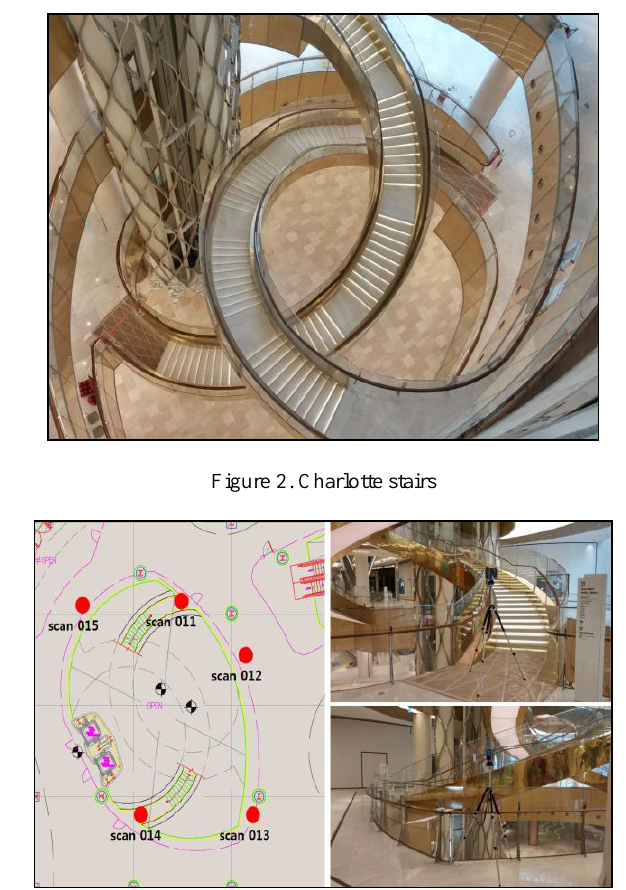
Figure 3. Scan position in 1 st floor and picture of position number 11,